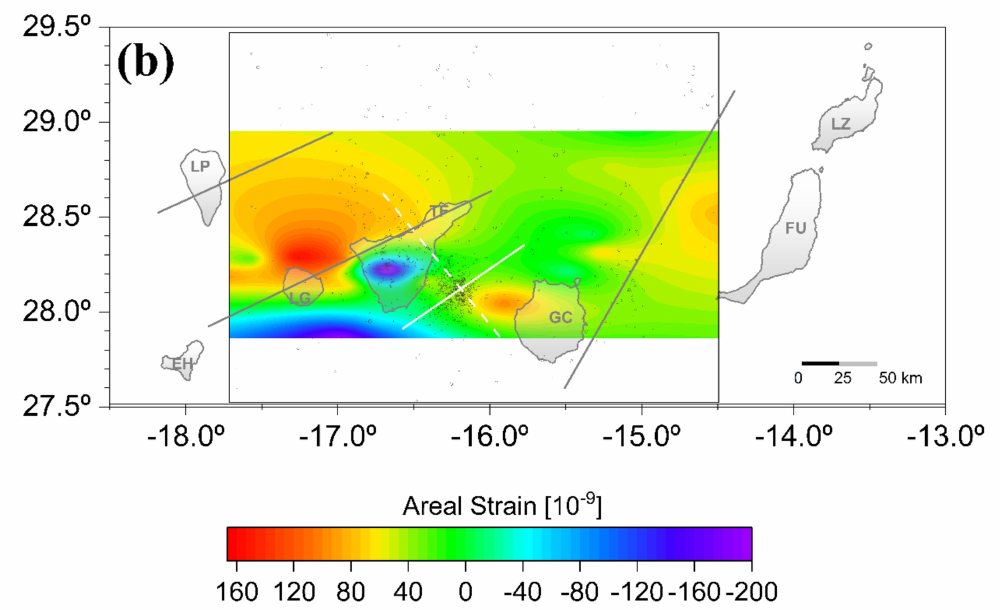
Figure 4. ( a ) Strain centroids determined by the principal axes of the 2D strain tensor calculated for 23 triangles established among the GNSS stations used in this study. Blue and red colours show tensile and compressive strain, respectively. ( b ) Contour map showing the areal strain distribution according to the colour bar. The thick white line represents the major fracture (submarine reverse fault between Gran Canaria and Tenerife), and the dashed white line is the secondary fault (inferred submarine alignment and slope break). The solid grey lines indicate other important volcano–tectonic features of the Canarian Archipelago (e.g., [28,33]). The grey circles are the epicentres of the earthquakes (m bLG > 1.2) recorded in the rectangular area during the period 2011–2017. EH: El Hierro; LP: La Palma;